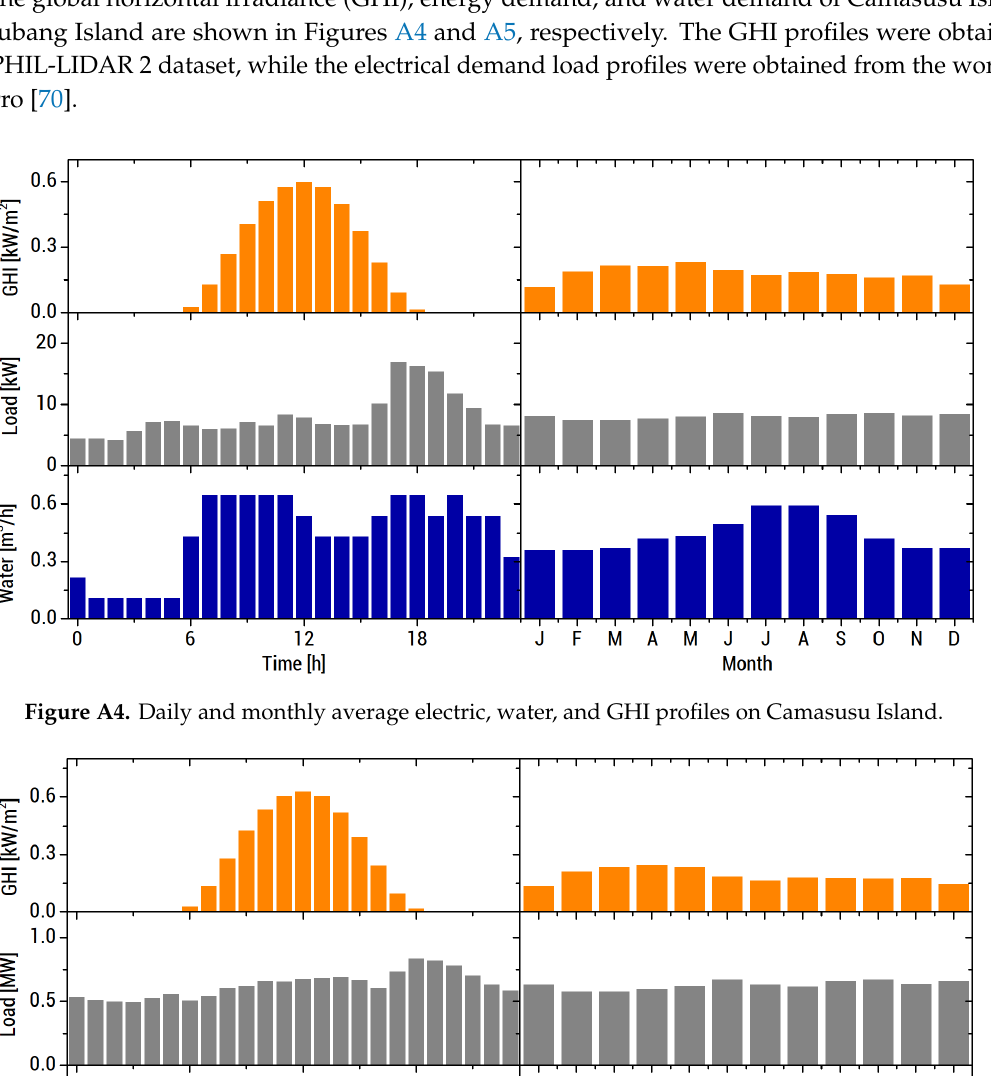
Table A2. Future cost parameters of energy components.